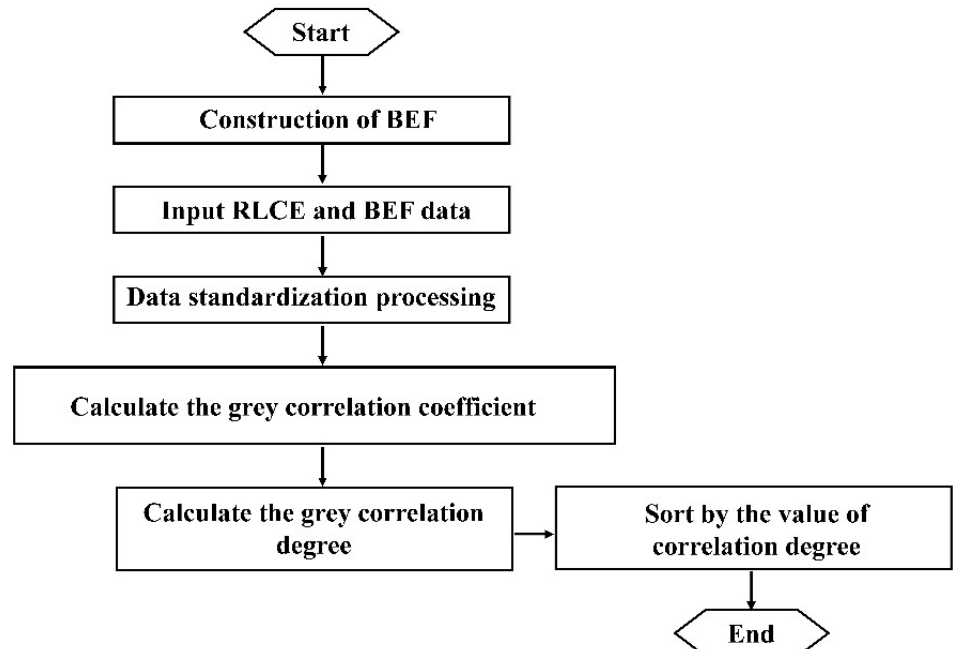
Figure 2. The flowchart of the Python code.